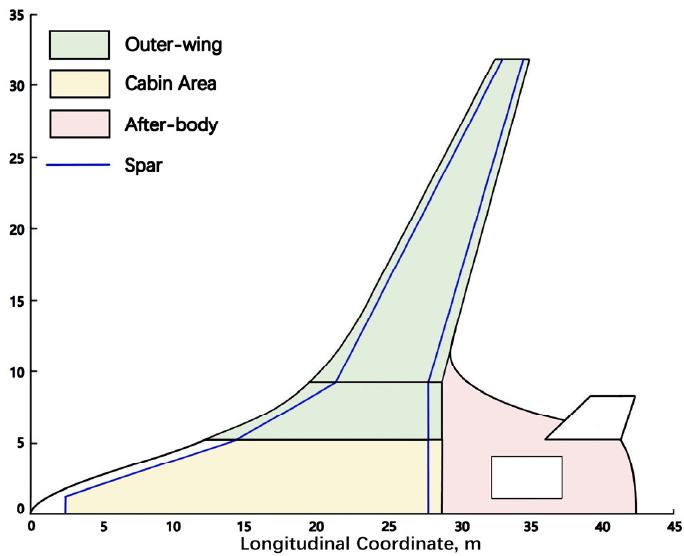
Figure 3. Internal layout of the HWB aircraft.